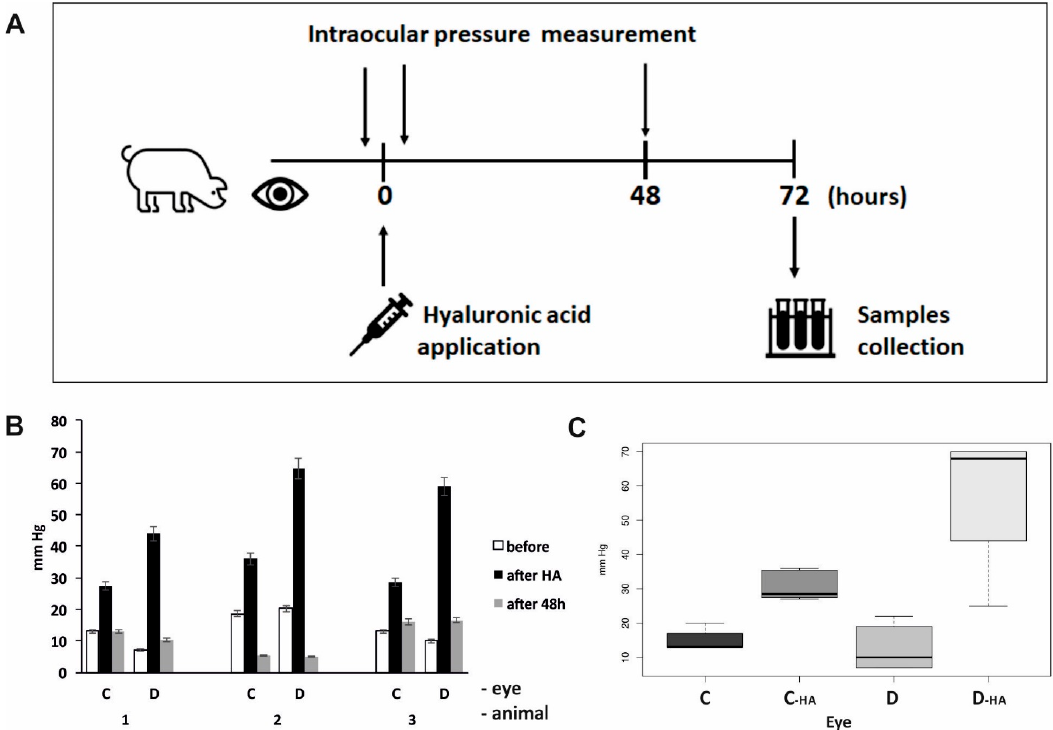
Figure 1. Monitoring of intraocular pressure during an experiment by iCare tonometer. ( A ) A simplified time chart of the experimental arrangement; ( B ) Intraocular pressure values in individual eyes. Means of minimum of six values are shown. HA—hyaluronic acid, C—control left eye, D—right eye after acute intraocular pressure elevation. (C) Differences between the pressure changes were analyzed using a linear mixed-effect model. Analysis was performed in a statistical package R, version 4.2.1. Before hyaluronic acid application, no difference between the control (C, n = 14) and treated eyes (D, n = 17) could be observed ( p = 0.6206). Increase in the intraocular pressure during the experiment was significantly higher in treated right eyes (D-HA, n = 18) compared to control left eyes (C-HA, n = 12) ( p =